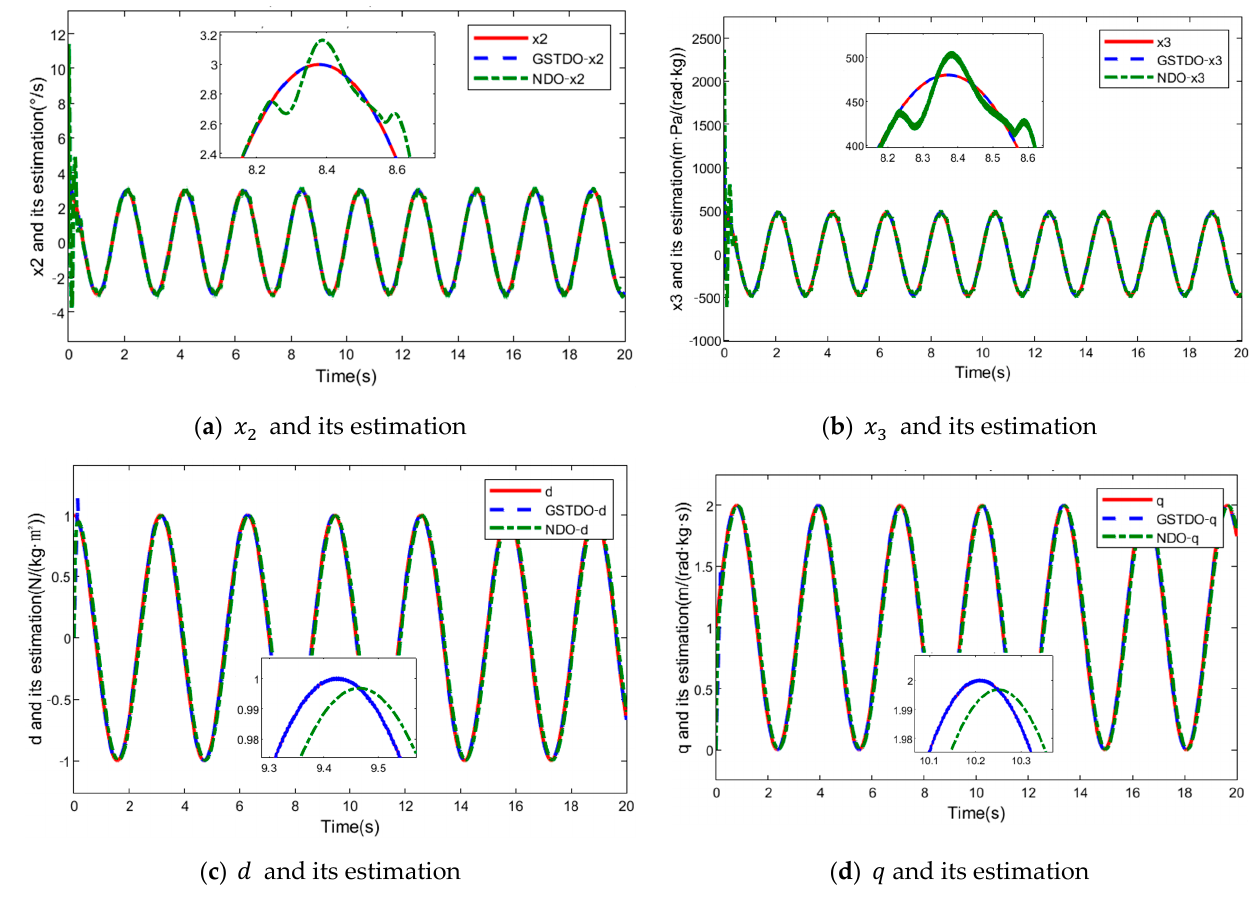
Figure 18. Comparison of the observational e ff ects of GSTDO and NDO in Experiment 3.